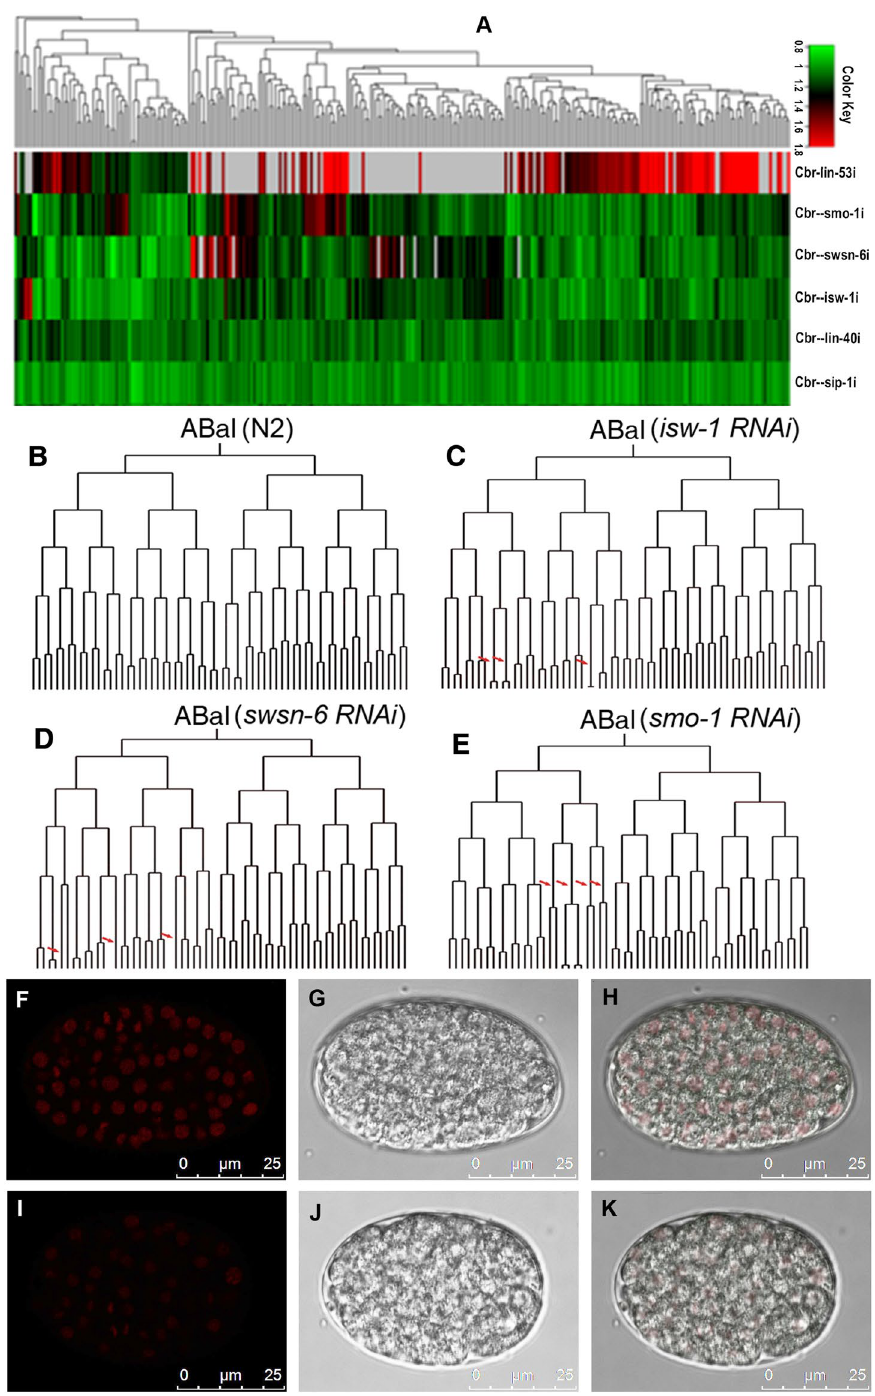
Figure 6. Roles of seven embryonically up-regulated proteins in cell division timing during C. briggsae embryogenesis. ( A ) Hierarchical clustering of cell division timings of RNAi embryos with genotypes indicated on the right. Up-regulation in division paces is colored in red and black and down-regulation in division paces in green. Cells absent in an RNAi embryo were shown in grey. ( B – E ) Lineage trees of a wildtype and RNAi embryos rooted with cell “ABal” up to roughly 350-cell stage with horizontal line indicating a cell division and vertical line division timing. For a full lineage tree rooted with a zygote, see Fig. S1. Significant changes in cell division timing relative to wildtype (N2) are indicated by a red arrow. The genotypes are shown above the tree. ( F – K ) Epifluorescence, Nomarski and their superimposed micrographs for a wildtype ( F – H ), approximately 350-cell stage) and a let-418 RNAi embryo (arrested at approximately 200-cell stage), respectively. Note the reduced expression intensity of histone marker (HIS-72::mCherry) before ( F ) and after ( I ) the